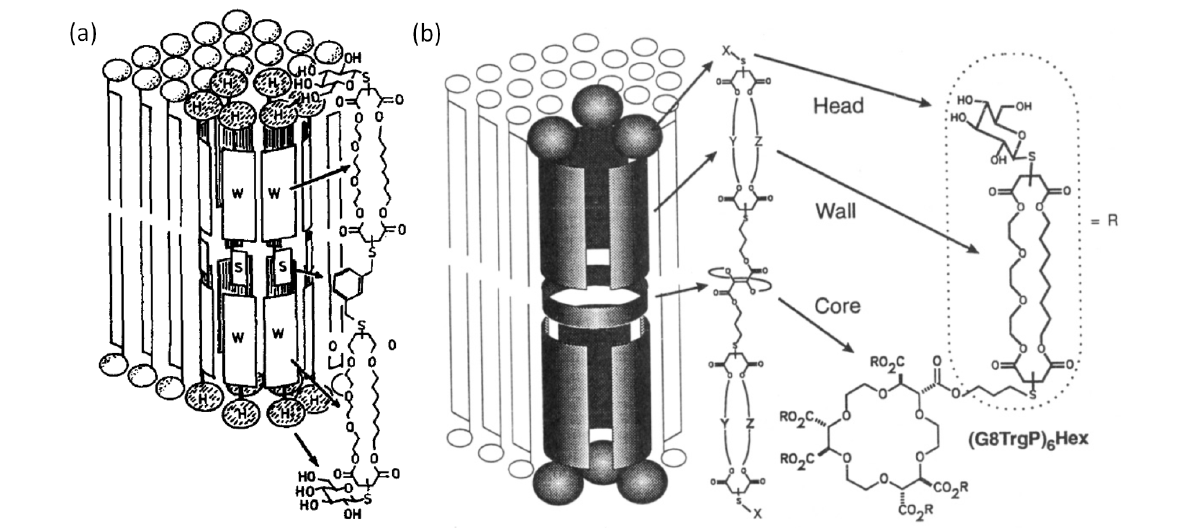
Figure 1: (a) Supramolecular pore formers. Reproduced with permission from [6]. Copyright 1990 Elsevier. (b) Unimolecular ion channel. Repro- duced with permission from [9]. Copyright 1993 The American Chemical Society.